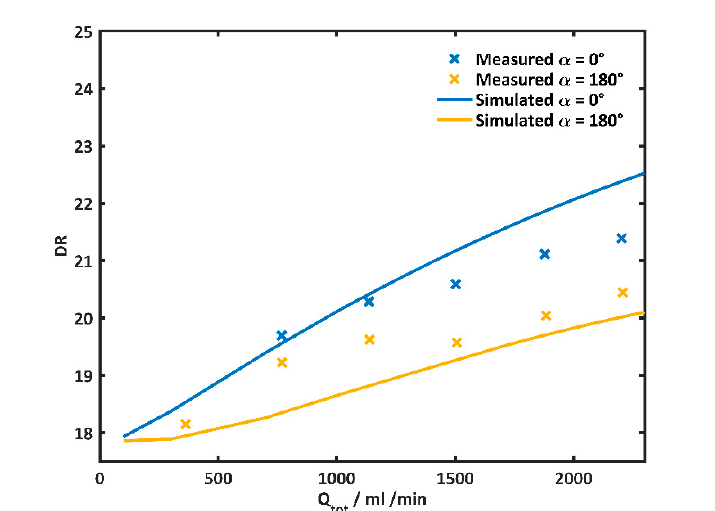
Figure 4. Comparison of the dilution ratio determined by flow measurements and simulations using COMSOL, for two different needle orientation angles α .